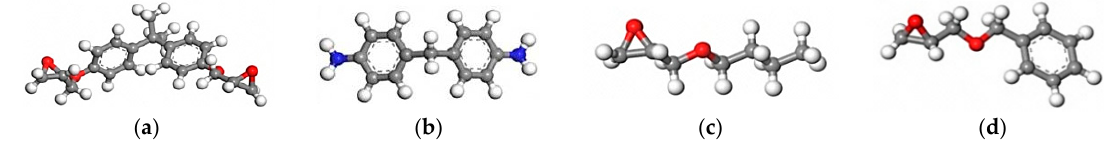
Figure 1. Simulated molecular structures employed in the molecular dynamic (MD) simulation: ( a ) diglycidyl ether of bisphenol A (DGEBA), ( b ) 4,4 ′ -diaminodiphenyl methane (DDM), ( c ) n -butyl glycidylether (BuGE) and ( d ) benzyl glycidylether (BeGE), where carbon is shown in gray, oxygen in red, nitrogen in blue and hydrogen in white.